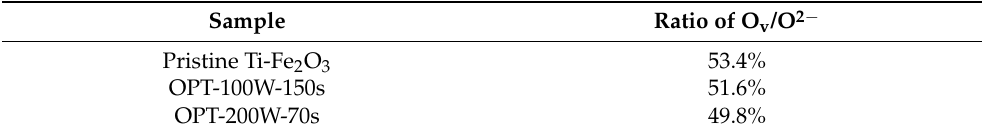
Table 3. The ratio of the integrated area of O v /O 2 − in the XPS spectra for the pristine Ti-Fe 2 O 3 ,